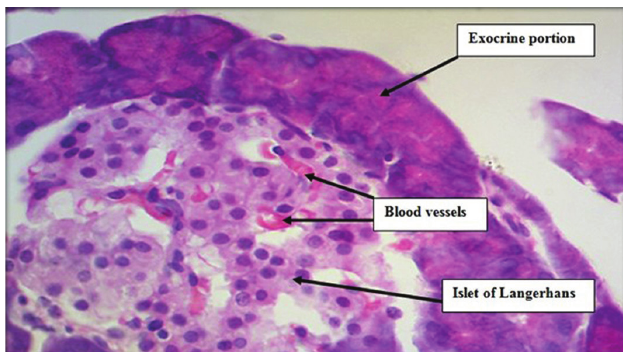
FIGURE 5 - Effect of normal saline on the pancreas of rats (H & E, 400x, 5 µ): Representative image of pancreas of rats treated with normal saline orally for three weeks showing islets of Langerhans, packed as compact and intact glandular mass.